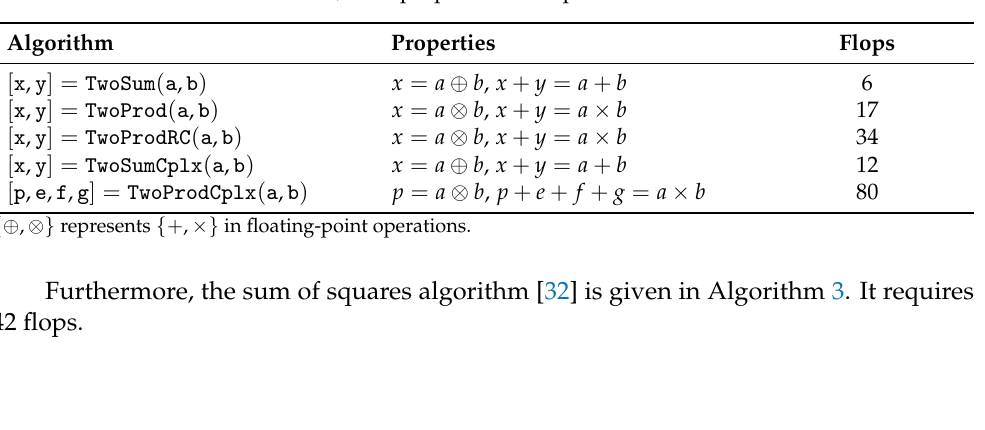
Table 1. Error-free transformations, their properties and operation